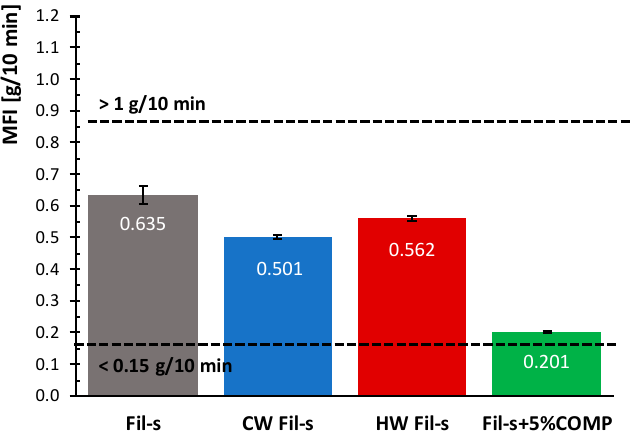
Figure 8. Comparison of the melt flow index (MFI) values for the analysed Fil-s based systems. The data relative to the first and last “MFI class”, as defined in ASTM D3350 standard, are also reported.